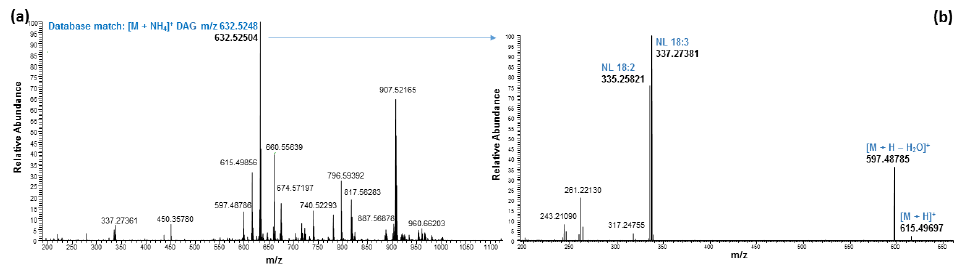
Figure 5. Mass spectra of DAG with molecular ion at m / z 632.52504 in positive mode eluted around 6.47 min ( a ) and fragmentation ions corresponding to a neutral loss- NL ( b ).